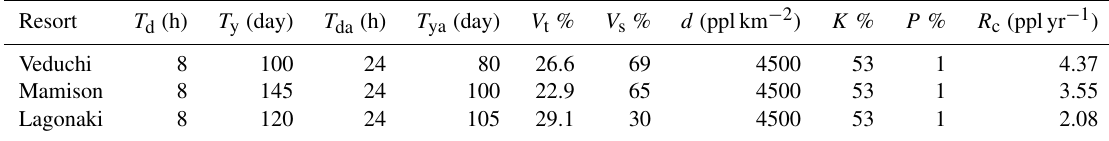
Table 3. Equations (1), (2) and (3) index values in Lagonaki, Mamison and Veduchi regions. Resort T d (h)